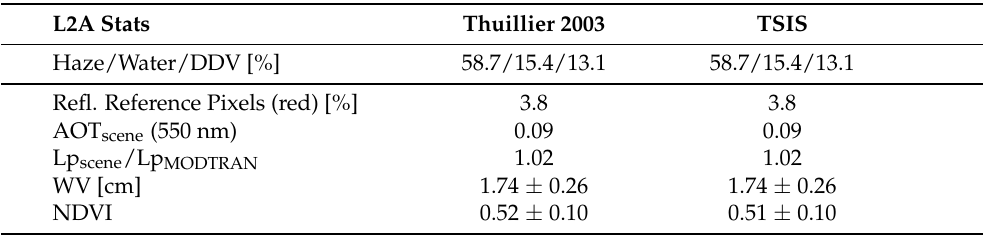
Table 1. L2A statistical results (mean and standard deviation) from the Sentinel-2 La Crau scene processing using Thuillier 2003 and TSIS solar models (consistent scenario).